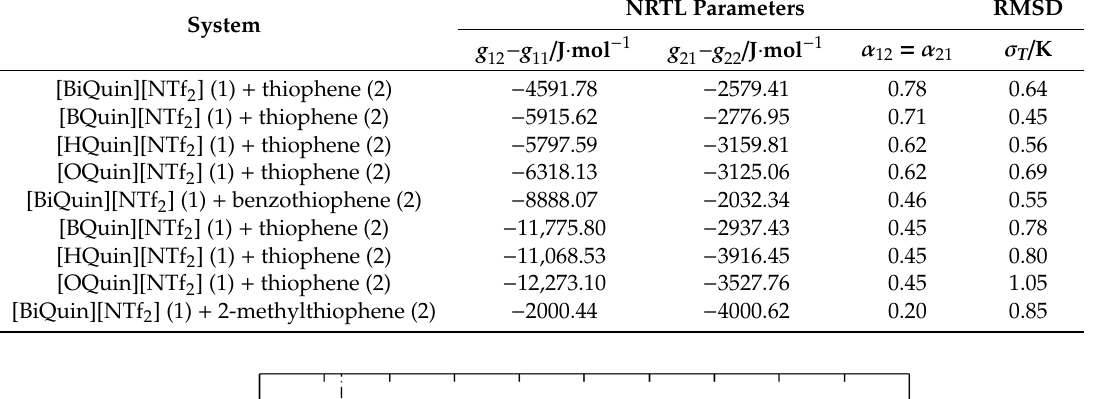
Table 5. The NRTL fitting parameters, obtained by the correlation of the SLE data for {IL (1) + organic sulfur compound or heptane (2)} binary systems.